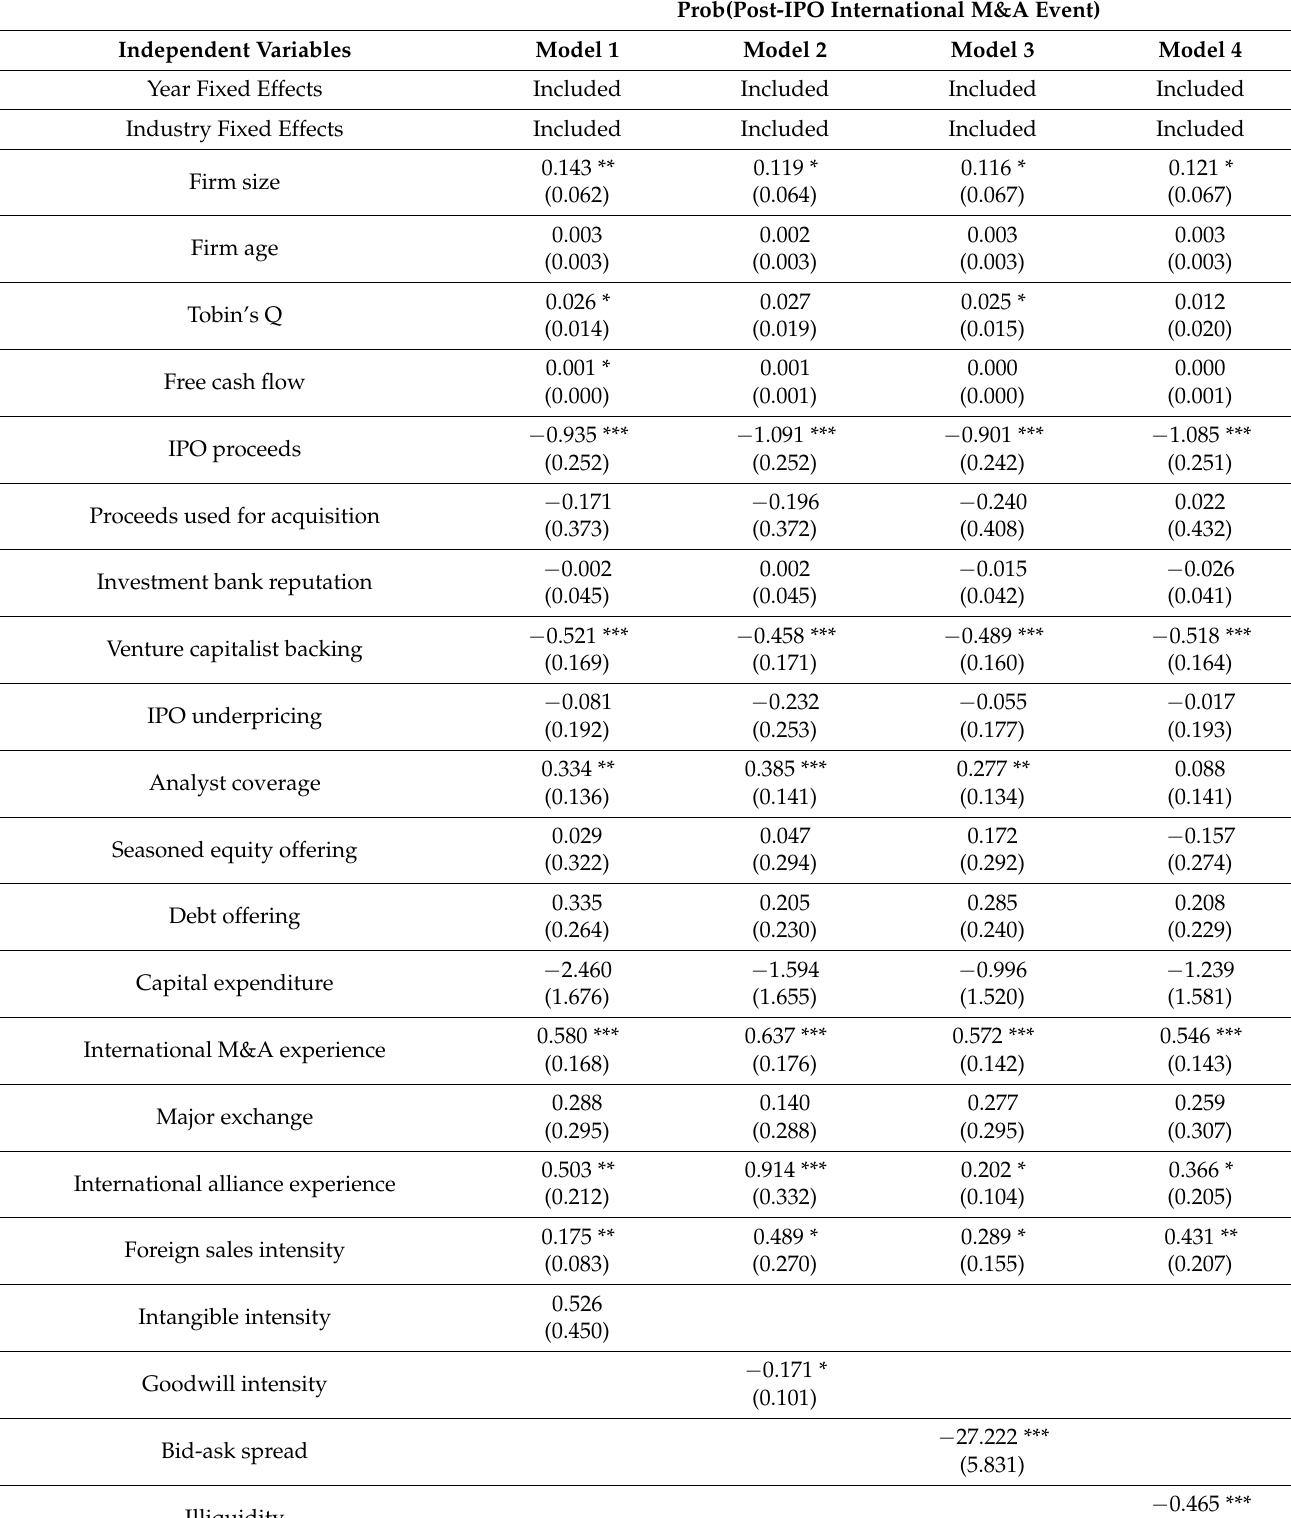
Table 6. Using Alternative Intangible Assets